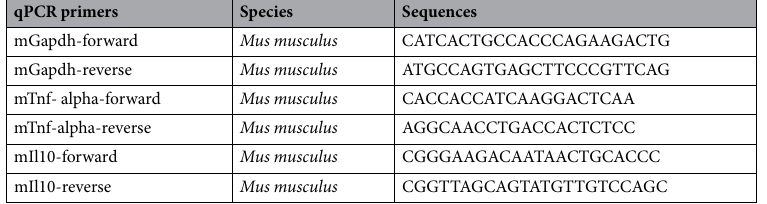
Table 2. qRT-PCR primers sequences.